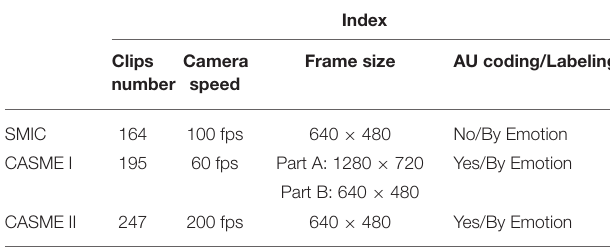
TABLE 1 | Three main spontaneous micro-expression